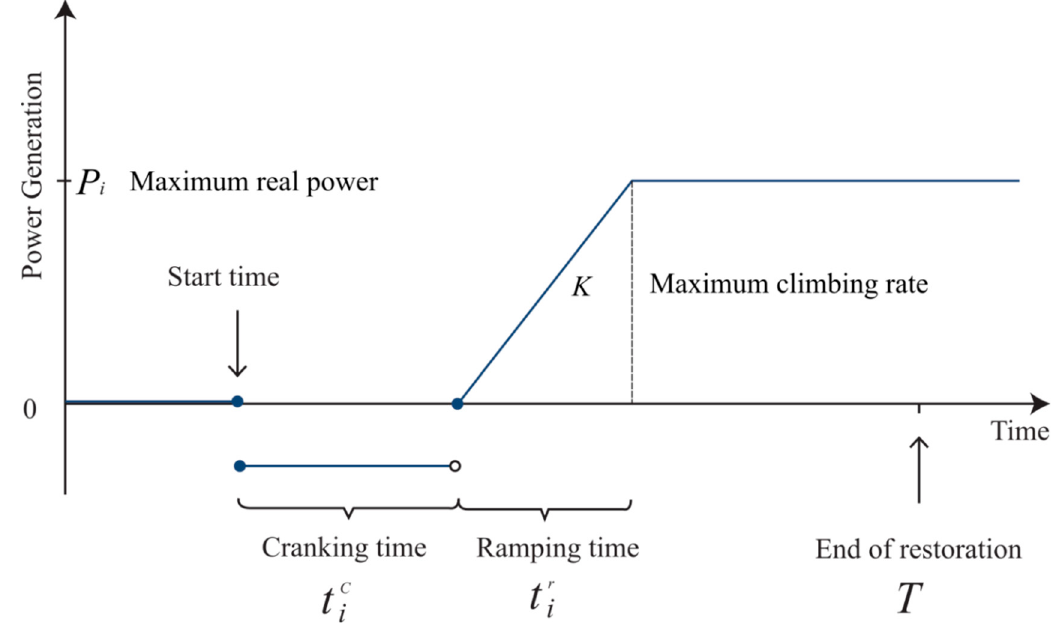
Figure 1. Ramp rate periods for a standard generating unit. The ramp rate is the increase of load that a generating unit can provide with respect to time.